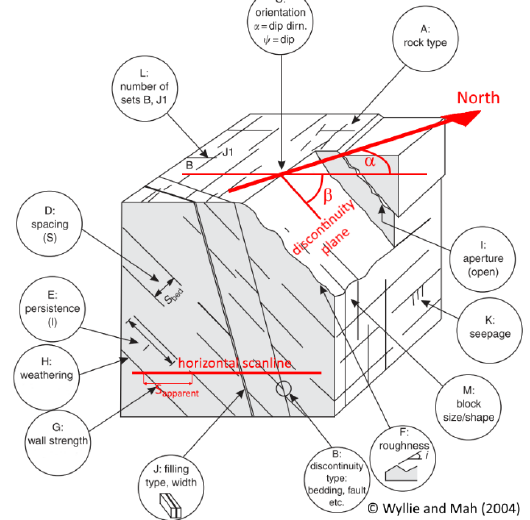
Figure 1. Characteristics of discontinuities in rock masses with parameters describing the rock mass; letters (“A” etc.) refer to description of parameter in chap. 3 of Wyllie and Mah (2004) (sketch extracted from Wyllie and Mah (2004) with information added in red colour by the